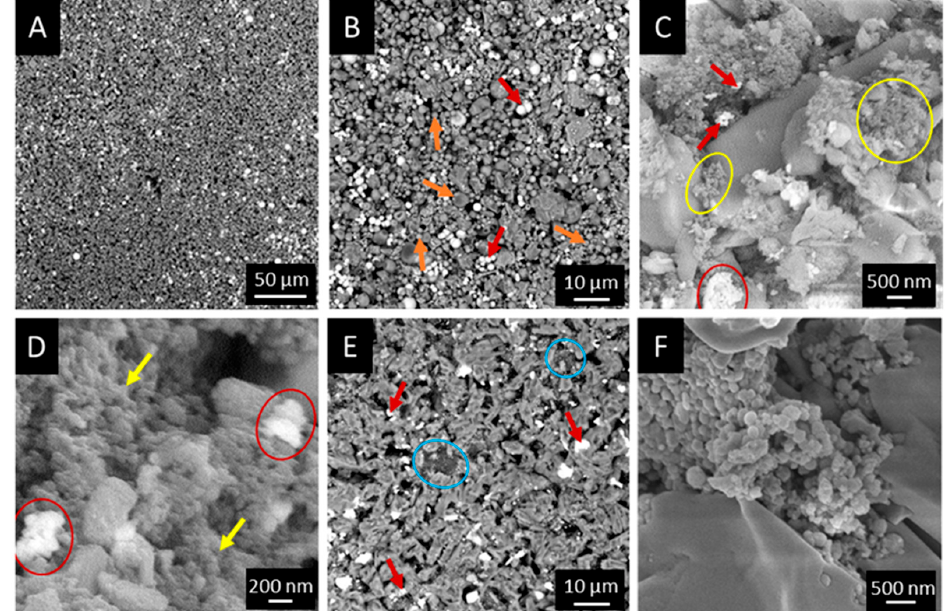
Figure 2. FE-SEM images of the composite cement: ( A ) Representative image to demonstrate the homogenous distribution of the powders within the CSD matrix (1000×); ( B ) Detail of the formula- tion with Sr-MBG-SD highlighting ZrO 2 nanoparticles (red arrow) and Sr-MBG-SD micrometrical particles (orange arrows) (3000×); ( C , D ) Details of the formulation with Sr-MBG-SG highlighting the nanometric Sr-MBG-SG (yellow circles) and ZrO 2 nanoparticles (red arrows and circle) (25,000× and 50,000×, respectively); ( E ) Details of ICOS_PLGA-containing formulation highlighting the ZrO 2 na- noparticles (red circles) and the nanometric polymeric carries (blue circles) that fill the empty space of the CSD matrix (3000×); ( F ) Particular of ICOS_PLGA carriers in the CSD matrix (100,000×). Fluoroscopy and Micro-CT analyses were completed on the selected formulations to assess the radiopacity grade, as well as the distribution of the ZrO 2 nanoparticles through- out the cement volume. The level of radiopacity achieved by using 5% vol. of ZrO 2 nano- particles was sufficient for the clinical application of interest as it allowed to provide a radiopacity comparable to the commercial reference, Cerament ® (Figure 3A). Moreover, CTVox images showed that radiopaque nanoparticles were uniformly distributed on the edge of the sample, as well as throughout the analyzed volume (Figure 3B,C, respectively),